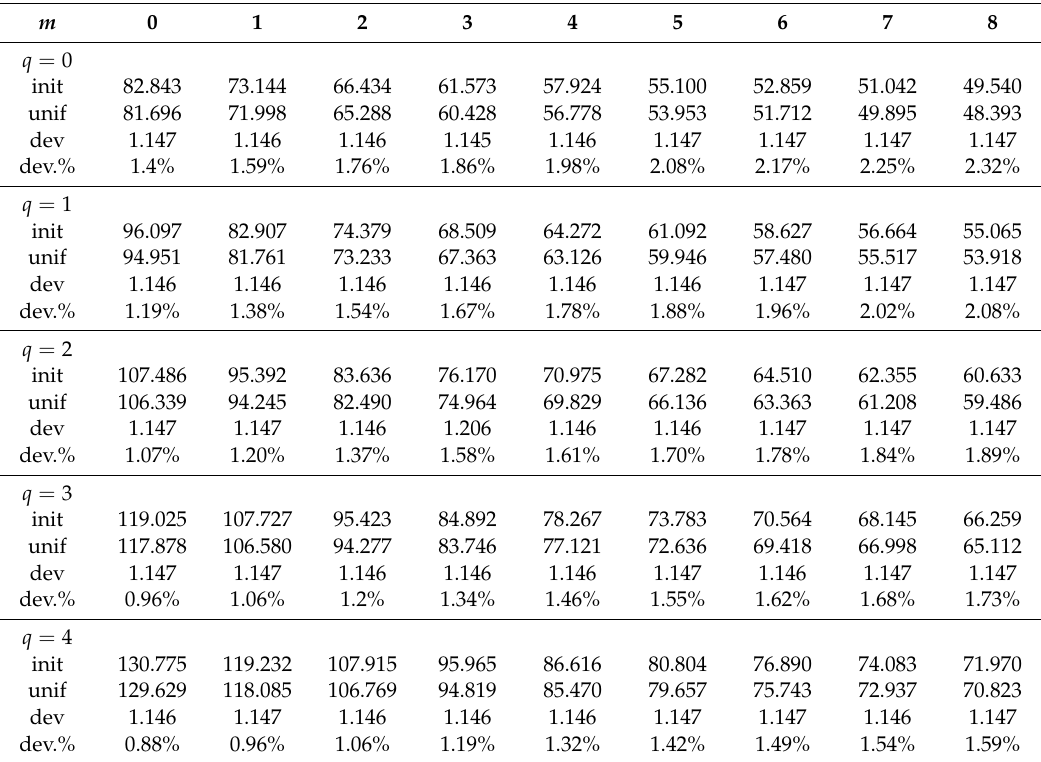
Table 1. Total discounted costs of initial and modified optimality equation. M = 8, σ m = 5, m = 0, ...